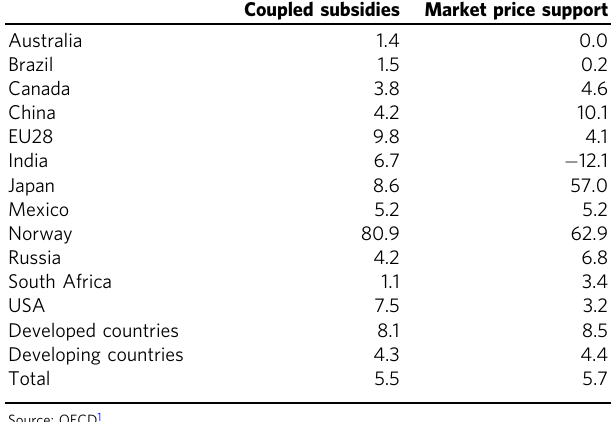
Table 1 Coupled subsidies vs market price support, 2017 – 19